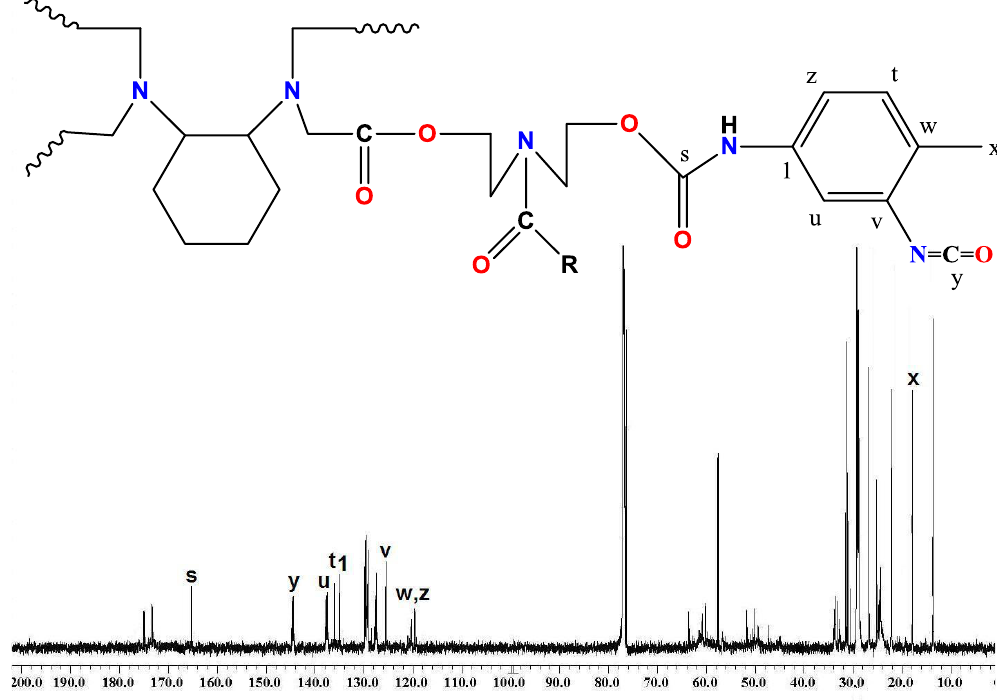
Figure 6. 13 C NMR spectra of PUDCEA Figure 6: 13 C NMR spectra of PUDCEA.